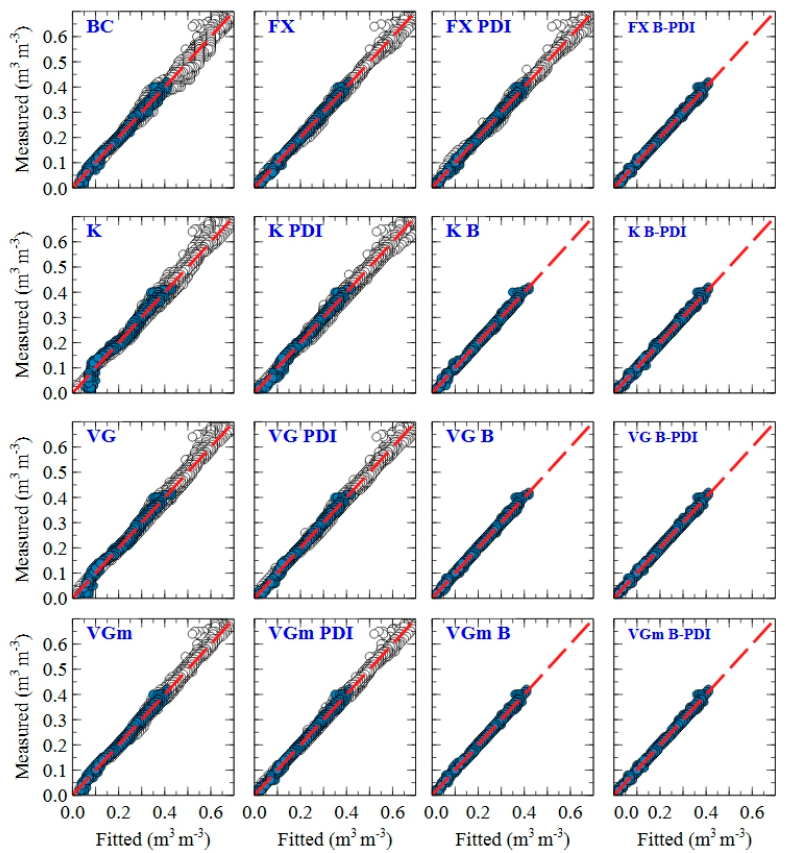
Figure 4. Scatter plots of fitted versus measured soil water content for all 16 models. The while and blue circles depict Turkish and USA data, respectively. BC: Brooks and Corey [7], FX: Fredlund and Xing [9], K: Kosugi [12], VG and VG m : van Genuchten [15] constrained and unconstrained unimodal